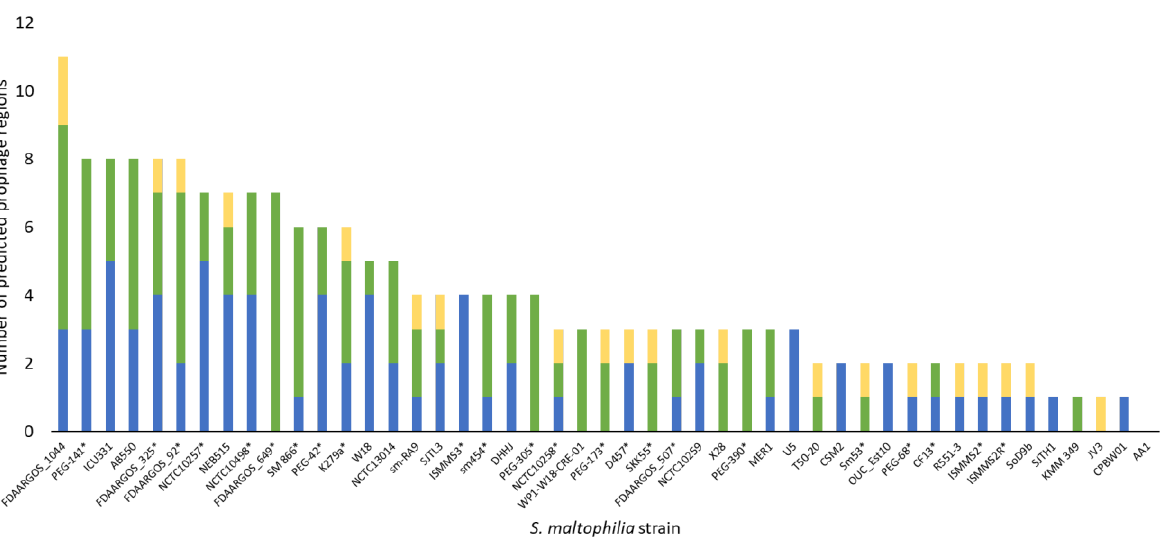
Figure 3. Prophage prevalence in 47 complete S. maltophilia genomes. Stacked bar graph showing the number of predicted prophage regions present in each S. maltophilia genome ranging from zero to eleven as determined by an updated version of PHAST [109,110]. Prophage regions are classified as intact (blue), incomplete (green), or questionable (yellow). Strains with * are clinical isolates and the remainder are environmental isolates, with the exception of FDAARGOS_1044, ICU331, NCTC13014, and NCTC10259 that are of unknown origin.